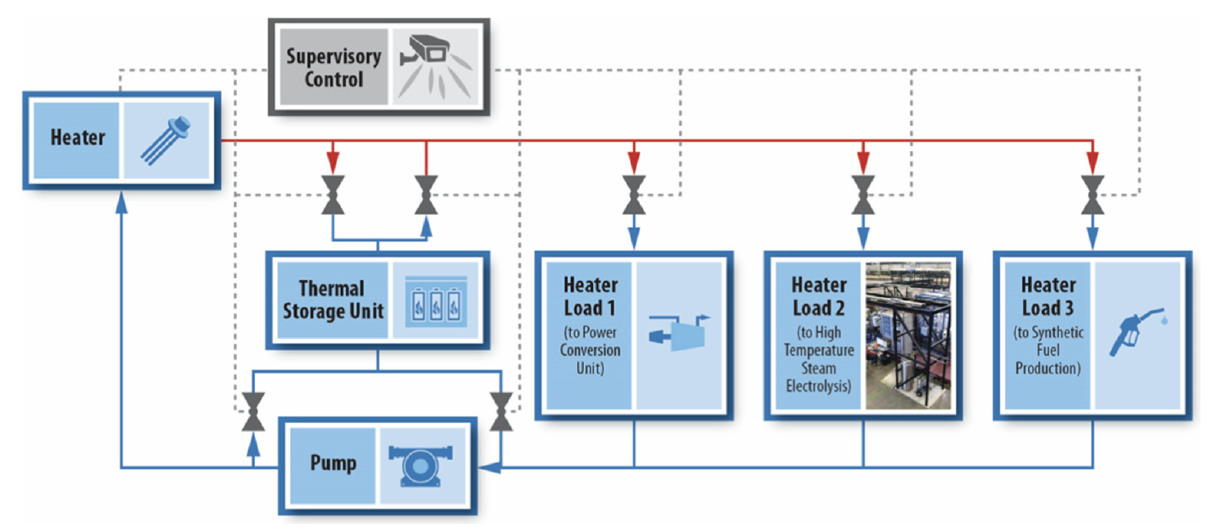
Figure 1. A TEDS schematic